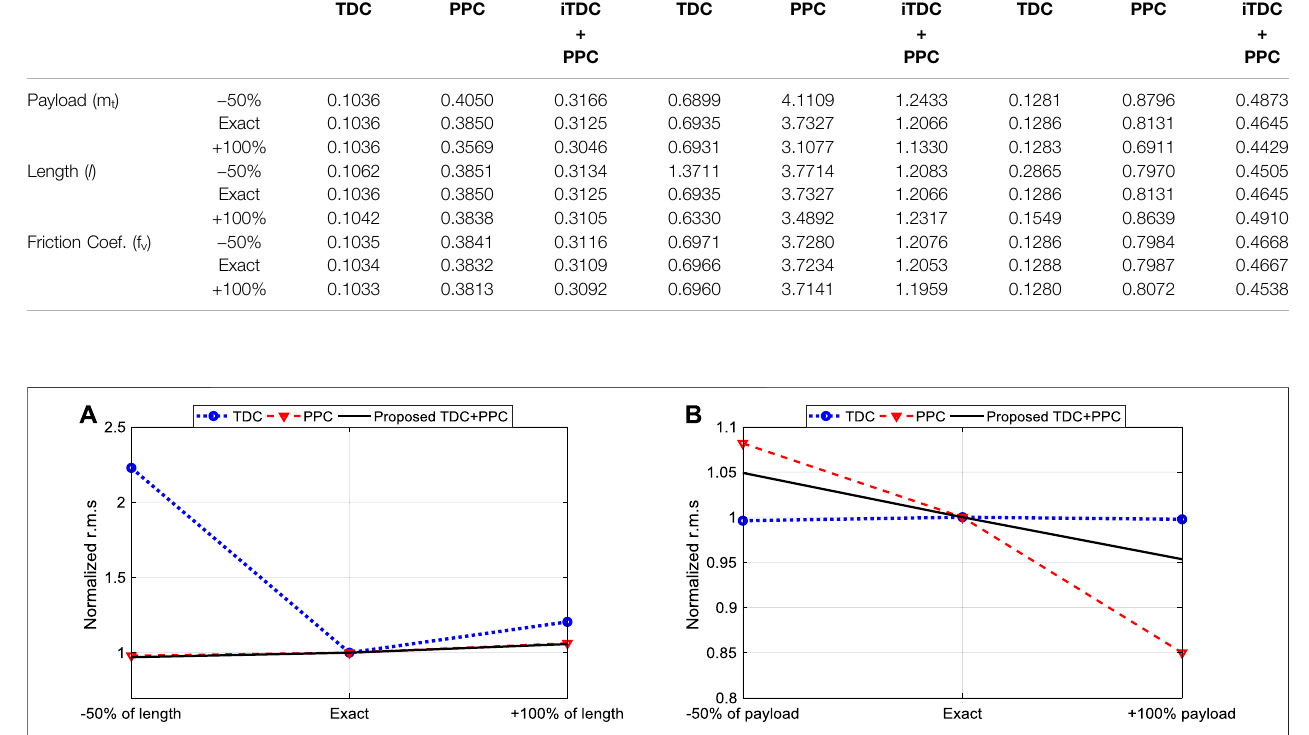
TABLE 2 | Robustness performance comparison for TDC, PPC, and iTDC + PPC.